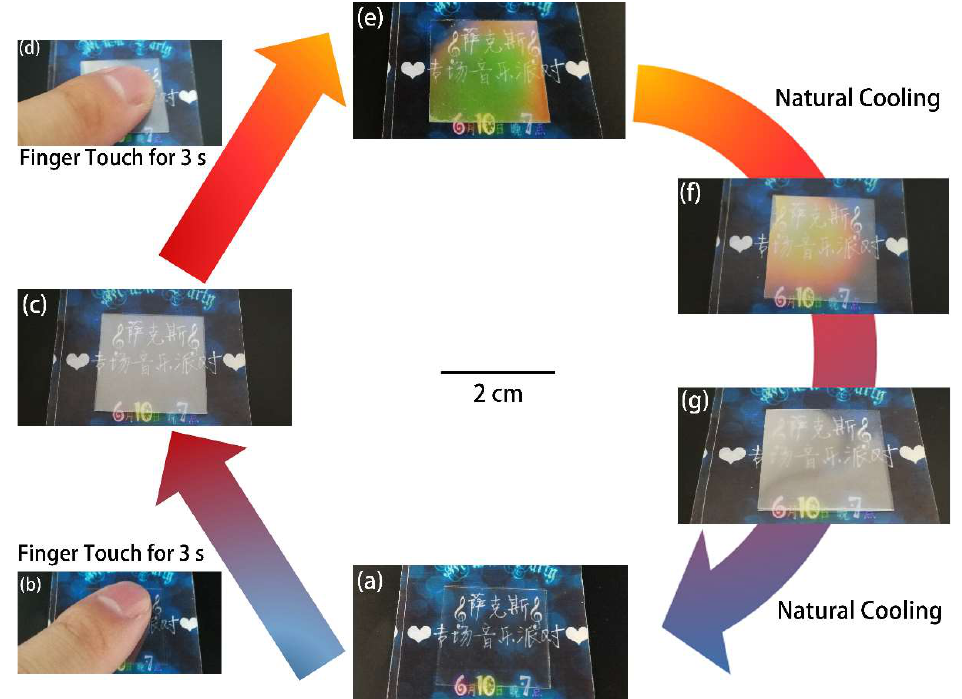
Figure 5. Pictures of the LC anti-counterfeiting label under finger touch: ( a ) transparent state at room temperature, ( b ) continuous finger touch for 3 s, ( c ) scattering state with smectic phase, ( d ) continuous finger touch for further 3 s, ( e ) reflection state with Ch phase, ( f ) both reflection and scattering states, and ( g ) scattering state with smectic phase during natural cooling.